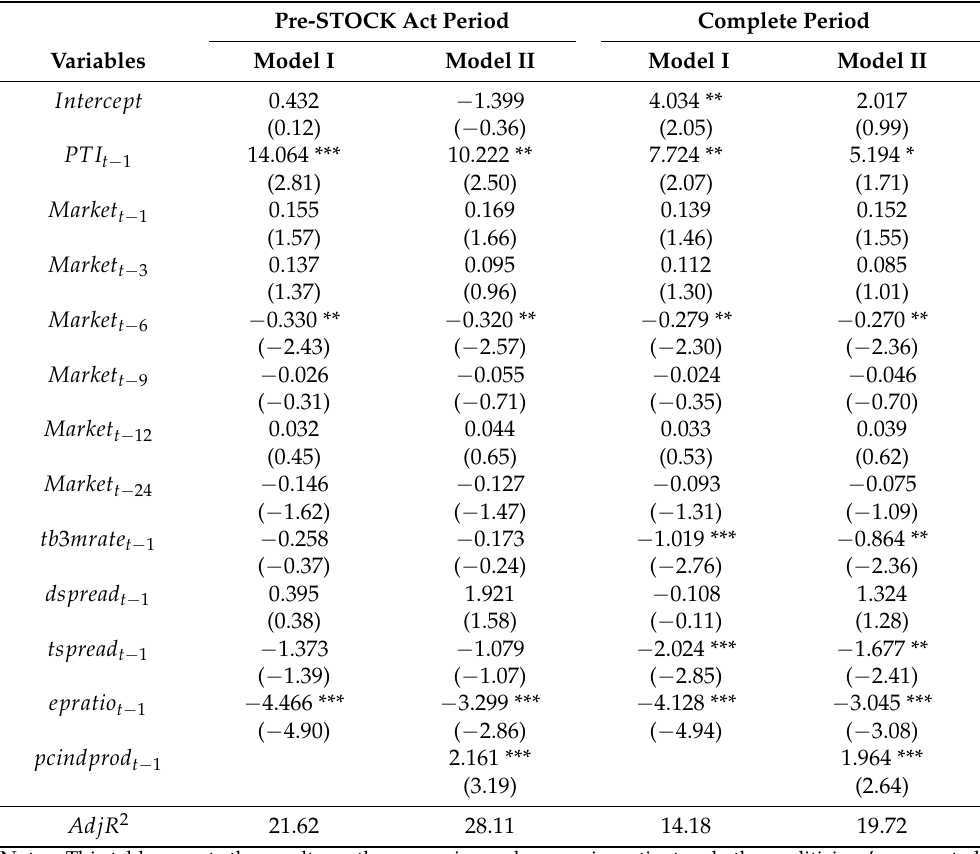
Table 2. Person-based trading index and equal-weighted market